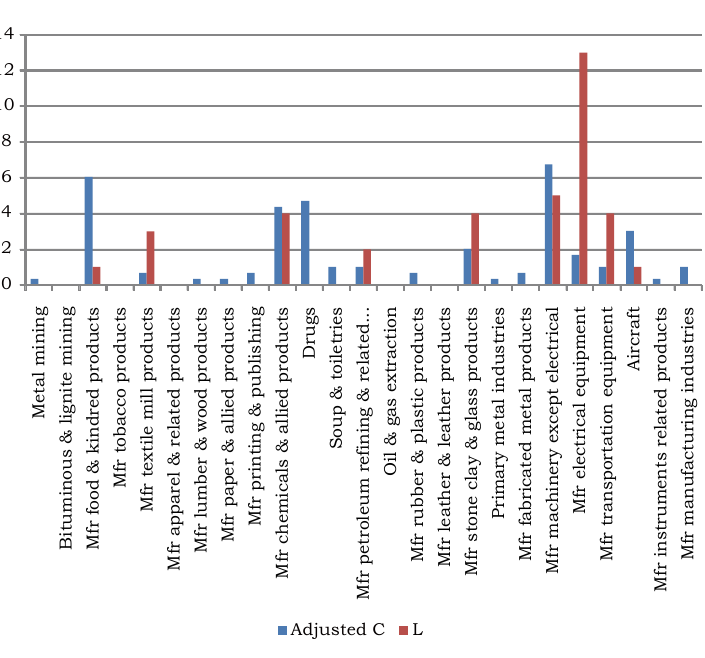
Figure 1. Frequency of adjusted C strategy and L strategy by